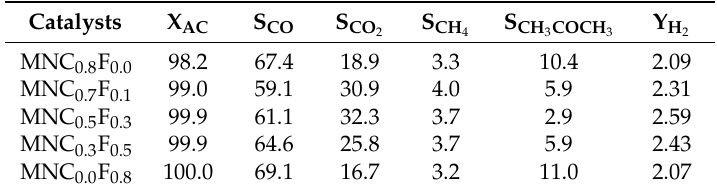
Figure 1. Auto-thermal reforming (ATR) of acetic acid (AC) over Ni-based catalysts at 650 ˝ C, Figure 1. Auto ‐ thermal reforming (ATR) of acetic acid (AC) over Ni ‐ based catalysts at 650 °C, 3.6 g ‐ 3.6 g-AC/(g-catalyst.h) and 1 atm. ( a ) MNC 0.8 F 0.0 ; ( b ) MNC 0.7 O 0.1 ; ( c ) MNC 0.5 F 0.3 ; ( d ) MNC 0.3 F 0.5 ; AC/(g ‐ catalyst.h) and 1 atm. (a) MNC 0.8 F 0.0 ; (b) MNC 0.7 O 0.1 ; (c) MNC 0.5 F 0.3 ; (d) MNC 0.3 F 0.5 ; (e) MNC 0.0 F 0.8 . ( e ) MNC 0.0 F 0.8 . Table 2. The average data of ATR of acetic acid over Ni ‐ based catalysts at 650 °C, 3.6 g ‐ AC/(g ‐ Table 2. The average data of ATR of acetic acid over Ni-based catalysts at 650 ˝ C, 3.6 g-AC/(g-catalyst.h) catalyst.h) and 1 atm. and 1